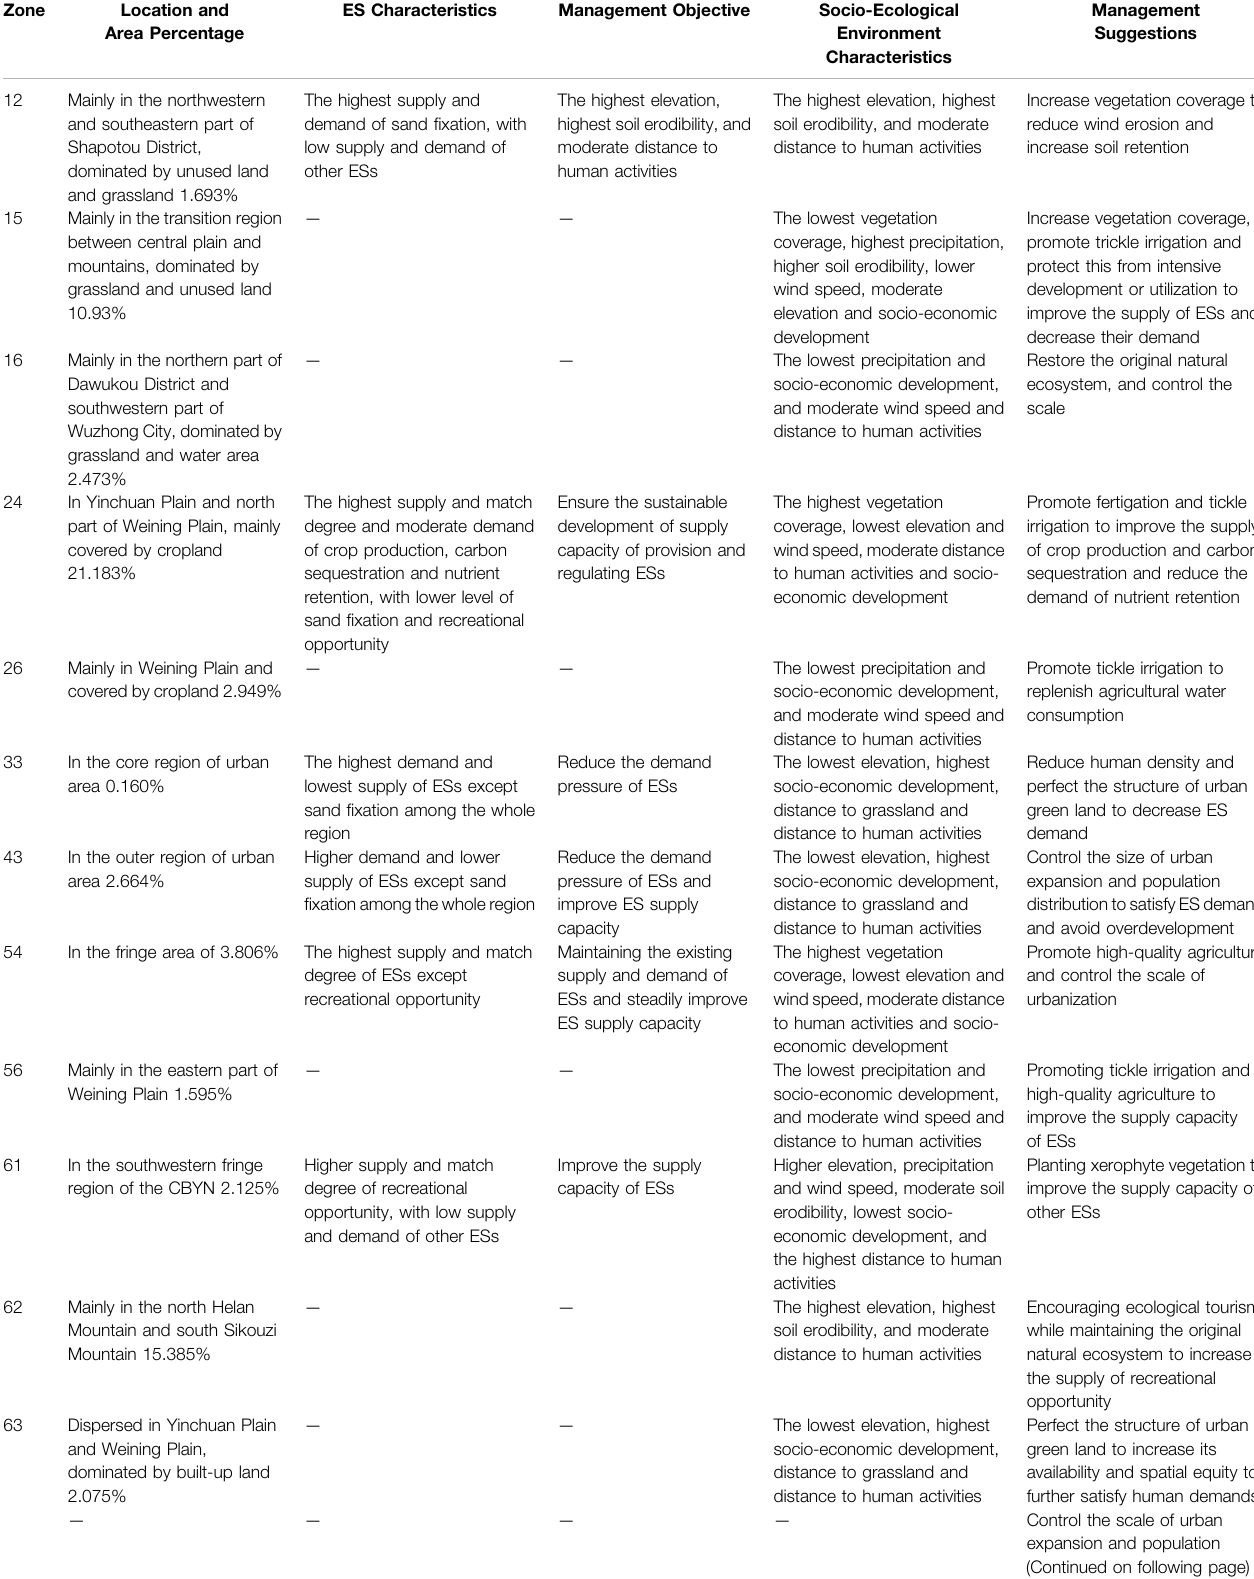
TABLE 7 | Ecosystem zoning management